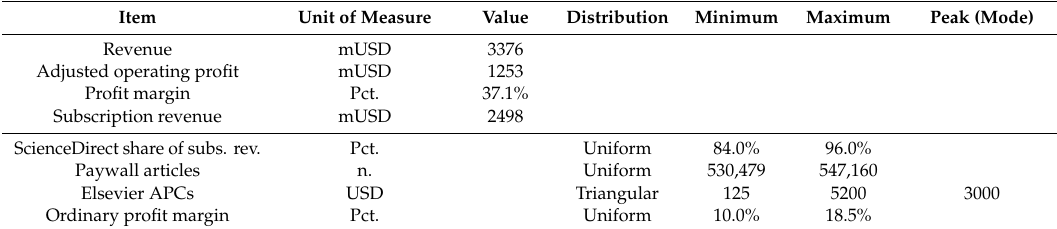
Table 4. Summary of data and assumptions for the Monte Carlo simulation